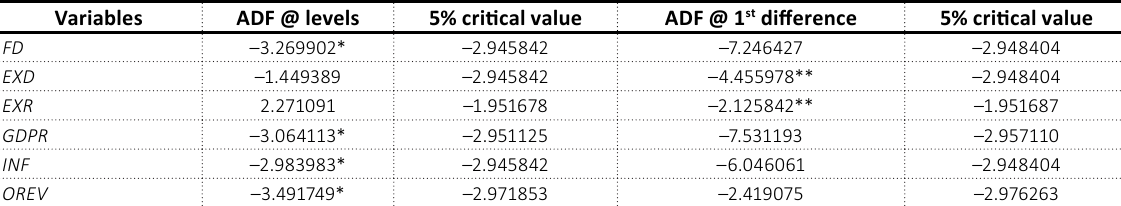
Table 1. Unit root